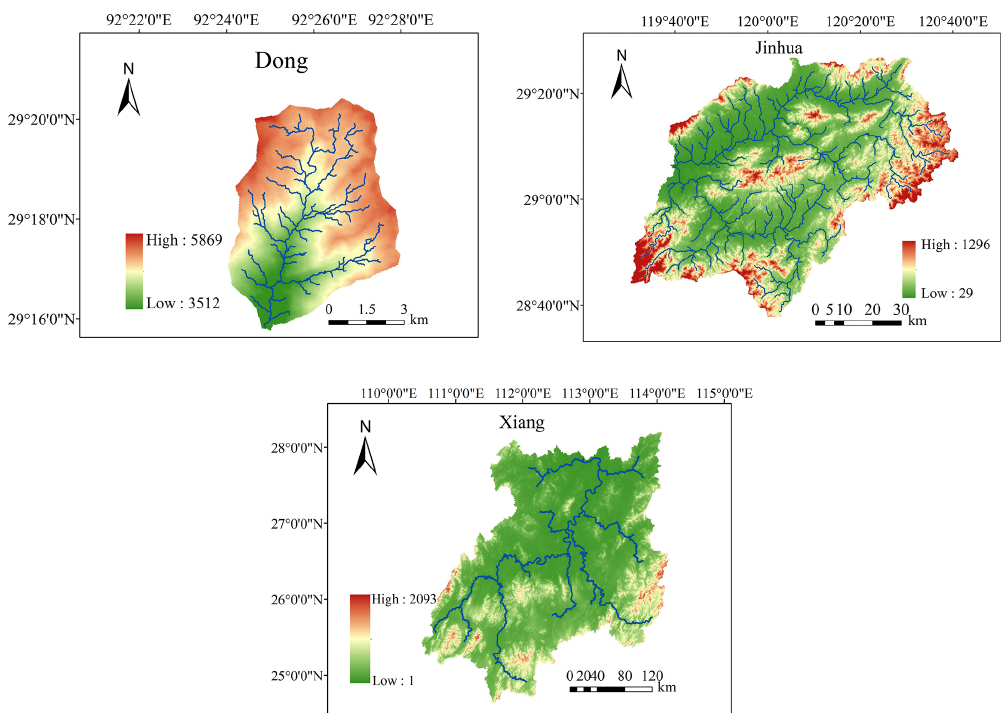
Figure 3. Digital elevation models of the study